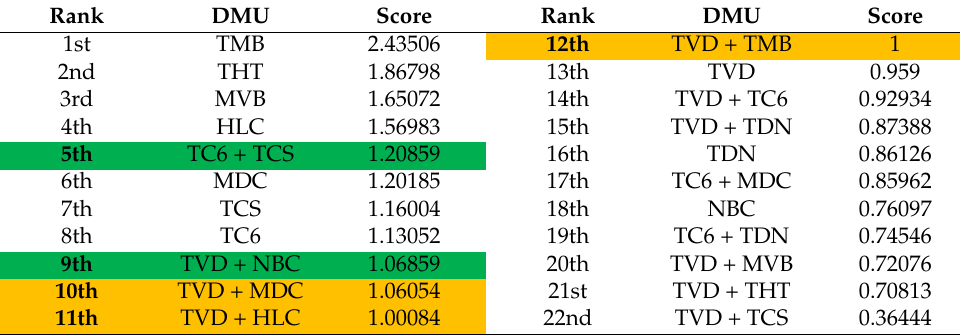
Table 11. Performance ranking of virtual alliance